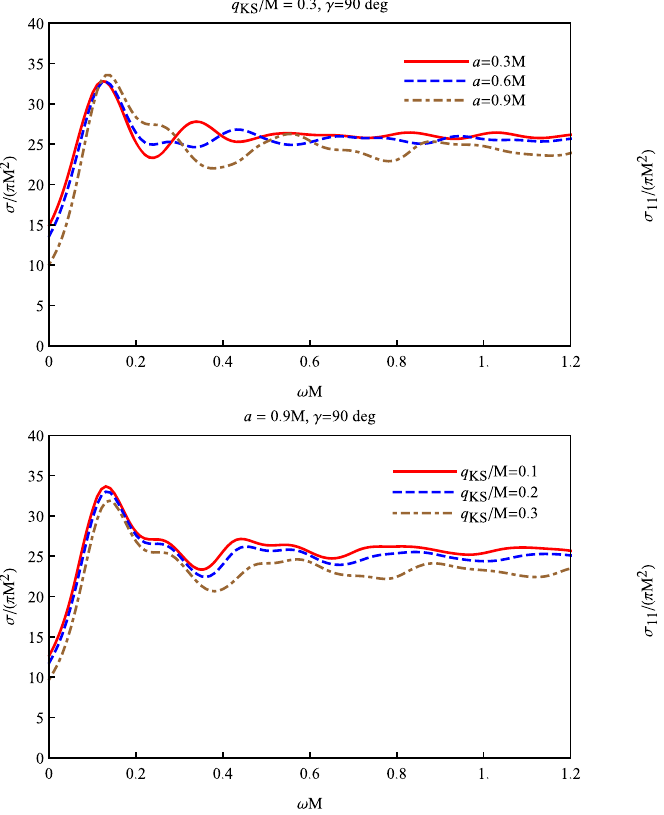
Fig. 6 Partial absorption cross section with l = m = 1, for fixed angu- lar momentum per unity mass (top) and normalised charge (bottom). Both panels are plotted for equatorial incidence ( γ = 90 ◦ ). The insets emphasize the occurrence of